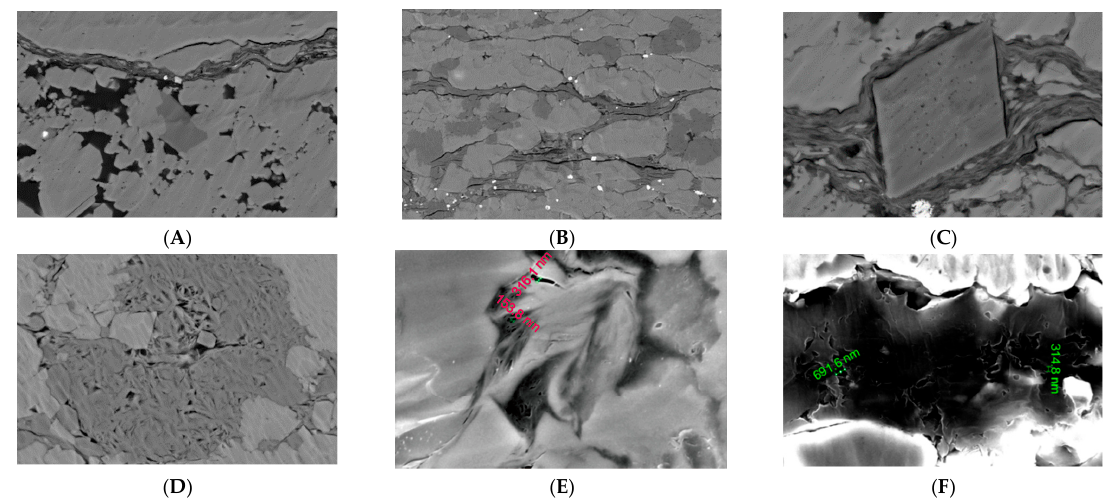
Figure 3. Types of pore development in the reservoir in the first member of Maokou Formation. ( A ) Residual asphalt of calcite intercrystalline pores in the Heping Well 1. ( B ) Calcite intercrystalline pores and micro-fractures in the Heshen Well 3. ( C ) Dolomite development corrosion holes in the Heping Well 1. ( D ) Talc shrinkage holes (fractures) in the Hebao Well 1. ( E ) Organic nanopores in the Heshen Well 3. ( F ) Irregular organic pores in the Heping Well 1.